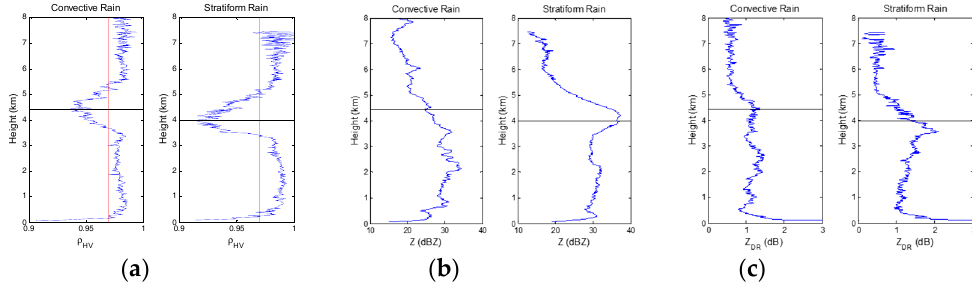
Figure 6. Averaged vertical profiles of ( a ) ρ HV , ( b ) Z and ( c ) Z DR at the same height for convective rain cell and stratiform rain cell at 05:45 UTC on 21st April 2014.